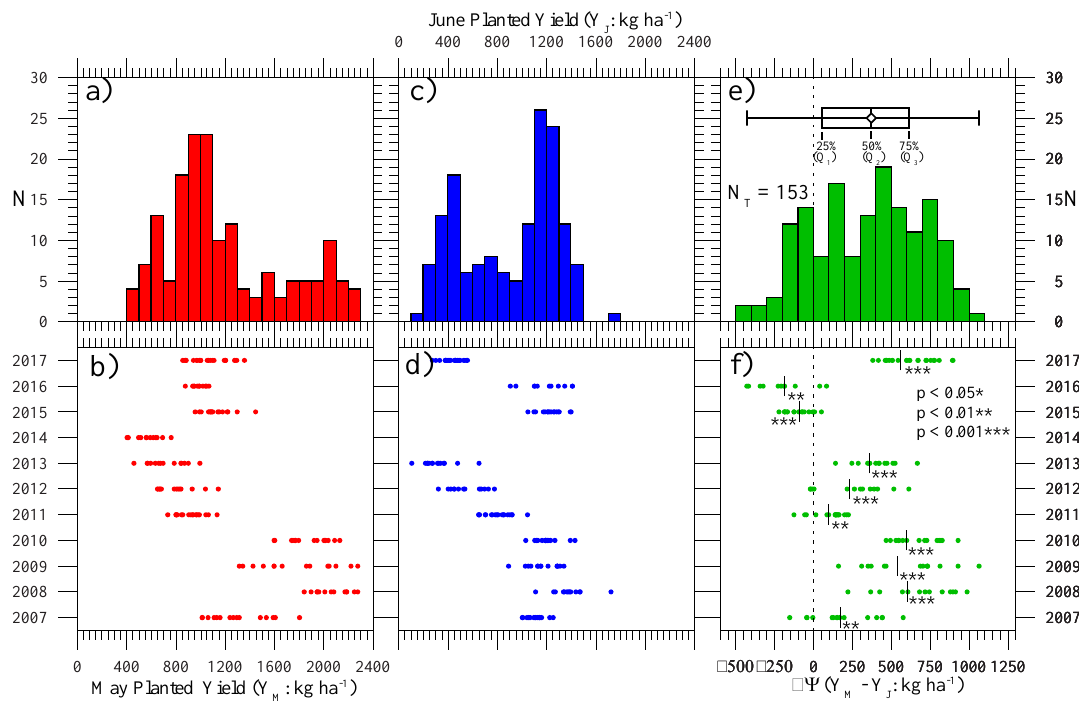
Figure 3. ( a ) Count histogram of May-planted lint yields from the 2007 – 2017 AgriLife irrigated variety trials. ( b ) May-planted lint yields by year. ( c ) As in ( a ) for June-planted yields. ( d ) As in ( c ) for June-planted yields. June-planted yields were not reported in 2014. ( e ) Count histogram of May-planted minus June-planted yield e ff ects ( ∆ Y) calculated from the same cultivar planted on May and June planting dates during each year. Bar plot marks the distribution’s minimum and maximum, and 25th (Q1), 50th (Q2) and 75th (Q3) percentiles. ( f ) Yield effects plotted by year. Vertical lines mark sample means. Stars show mean effects significant at at least a 95% confidence level ( p < 0.05) as determined by a one sample t -test.